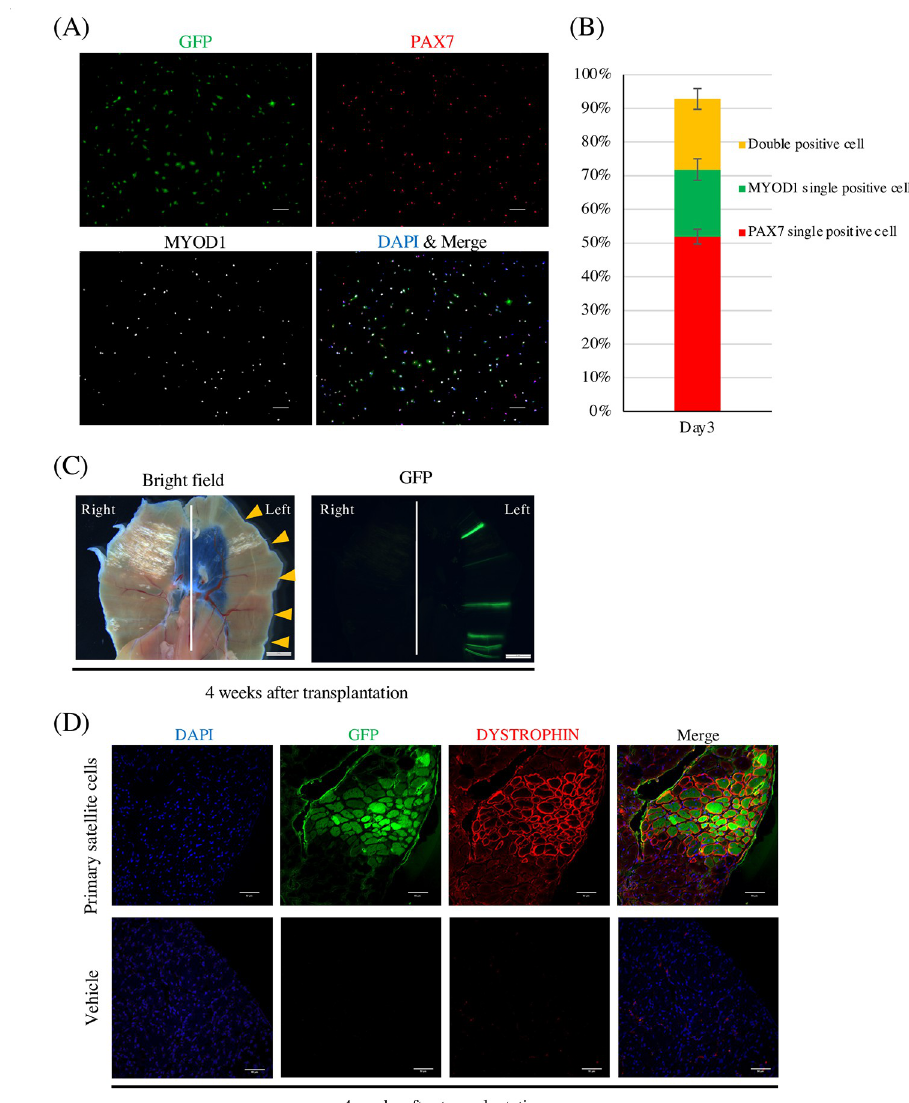
Fig 1. Primary satellite cells engrafted in the diaphragm. (A) Immunocytochemistry staining of isolated primary satellite cells after 3 days of culture. GFP (green), DAPI (blue), PAX7 (red), MYOD1 (white). Scale bars, 100 μ m. (B) Quantification of PAX7+MYOD–, PAX7+MYOD+, and PAX7–MYOD+ cell populations after 3 days of culturing primary satellite cells. Data show the mean ± SD. n = 3. (C) Representative images of the diaphragm by fluorescence stereomicroscopy 4 weeks after the transplantation. The cells were injected to the left side of the diaphragm, and vehicle was injected to the right side. Scale bars, 2 mm. Arrowheads show injection sites. (D) Representative immunohistochemistry staining of a cryosection. Sections were stained with anti-DYSTROPHIN antibody (red) and anti-GFP antibody (green). Nuclei were stained with DAPI (blue). Scale bars, 50 μ m. by FCM, the purity of the isolated cells was validated by myogenic marker expression after 3 days of culture (Fig 1A). Isolated cells were GFP positive (S1 Fig). More than 90% of cells were PAX7 and/or MYOD1 positive (Fig 1B), indicating good purity for the transplantation experi- ment. The cells were then transplanted into NOG-mdx mice by direct injection through the edge of the diaphragm. GFP signals were detected in the transplanted area (Fig 1C), and DYS- TROPHIN positive fibers expressing GFP derived from the transplanted cells were detected